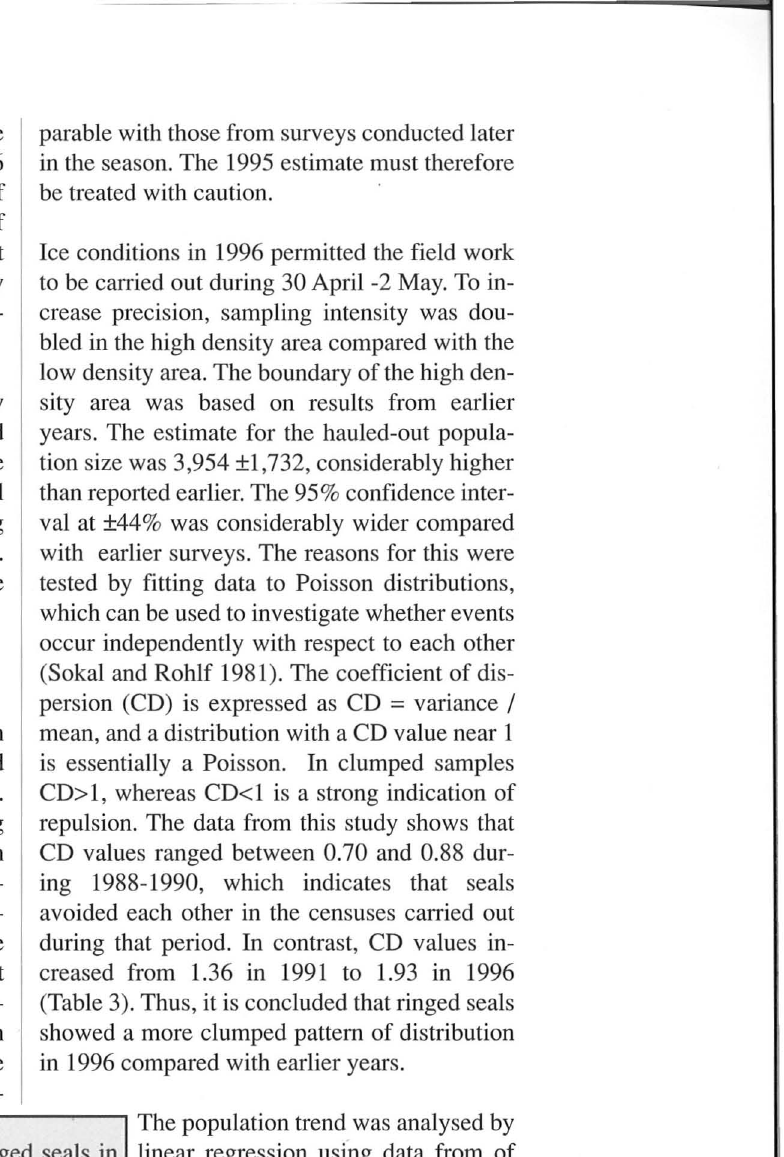
Table 2. Results of surveys of hauled-out ringed seals